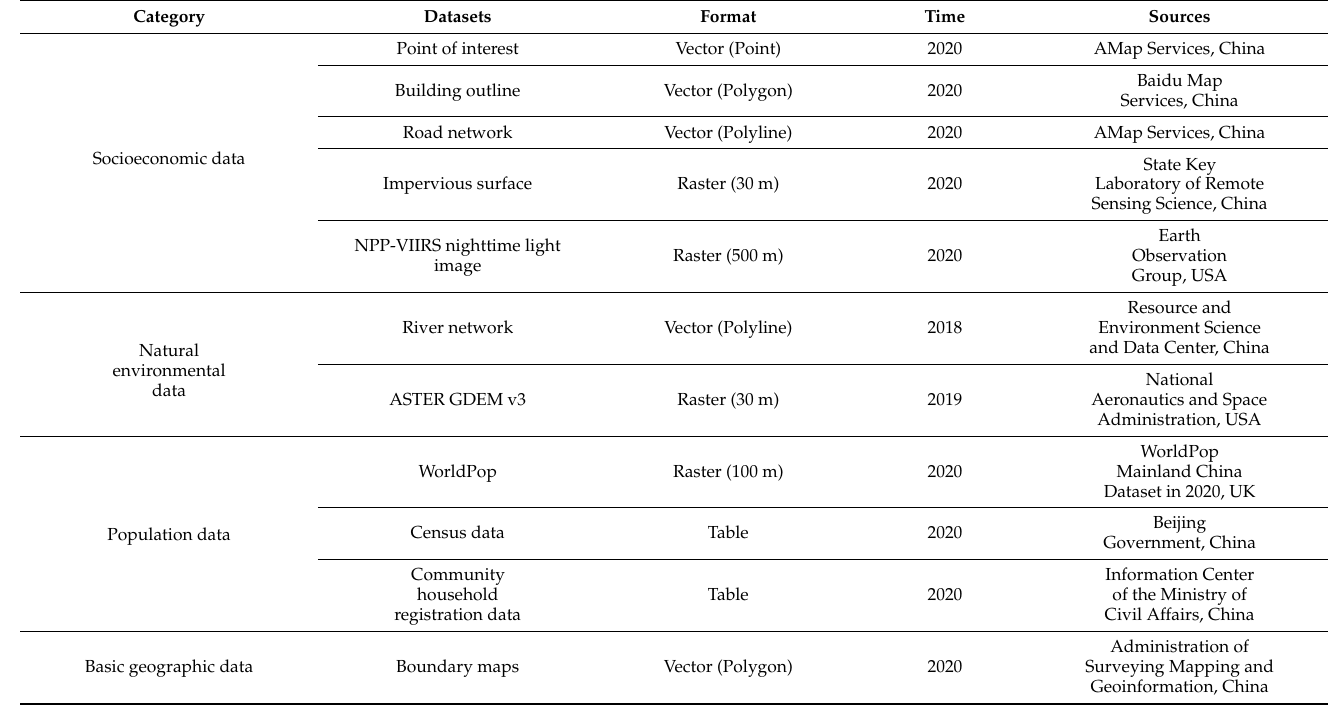
Table 1. List of datasets and sources used in the